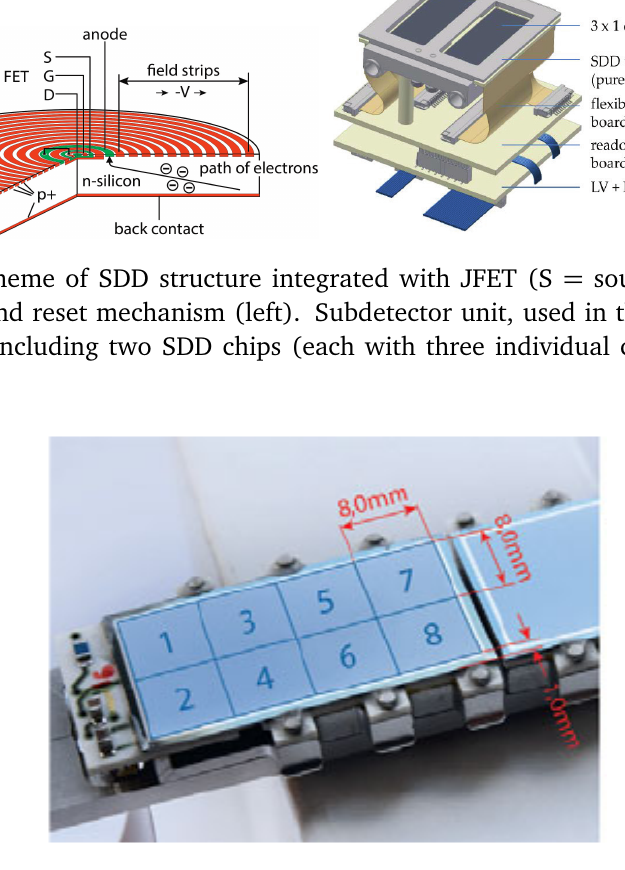
Figure 4: SDD chip consisting of 8 square cells installed on a ceramic carrier and aluminum block provided cooling. Adapted from [ 1 ]